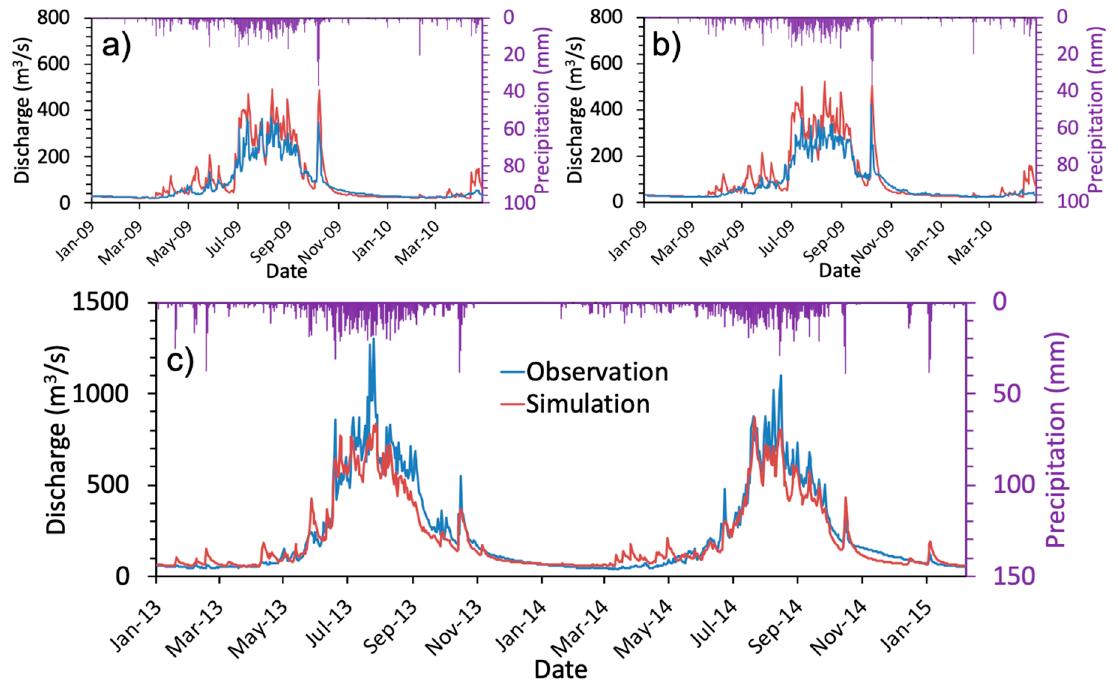
Figure 7. Additional validation of flows at supplementary stations in daily time step: ( a ) Budhigandaki KA, ( b ) Budhigan- daki KHA and ( c ) BGHEP dam site. Precipitation data are shown in the inverted secondary y -axis as purple bars.